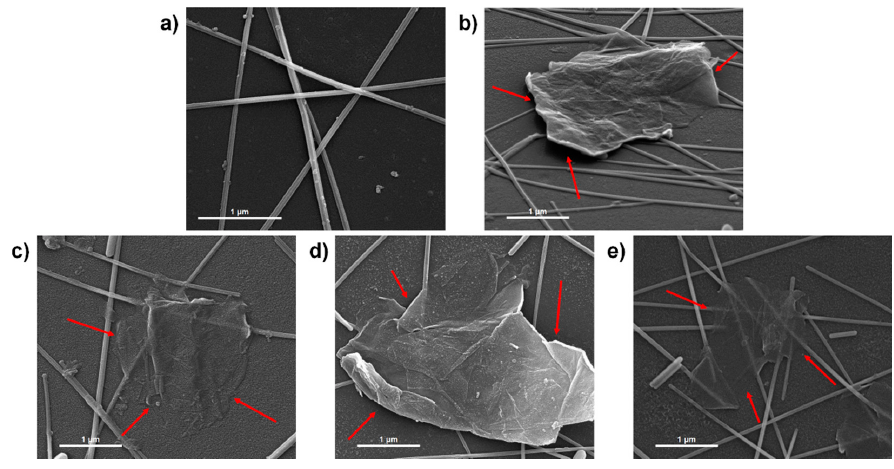
Figure 4. SEM images. ( a ) AgNWs on PET, ( b ) GCA 1:1 –AgNW before annealing, ( c ) annealed GCA 1:1 –AgNW, ( d ) GCA 2:1 –AgNW before annealing, ( e ) annealed GCA 2:1 –AgNW.